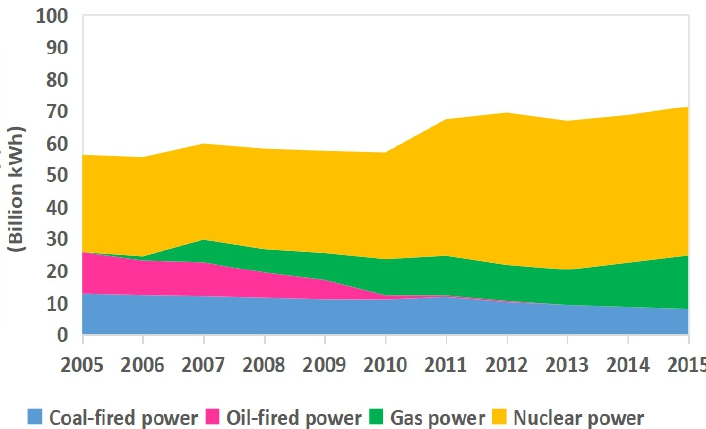
Figure 1. Changes in the energy components from different types of power plants in Shenzhen from 2005 to 2015.